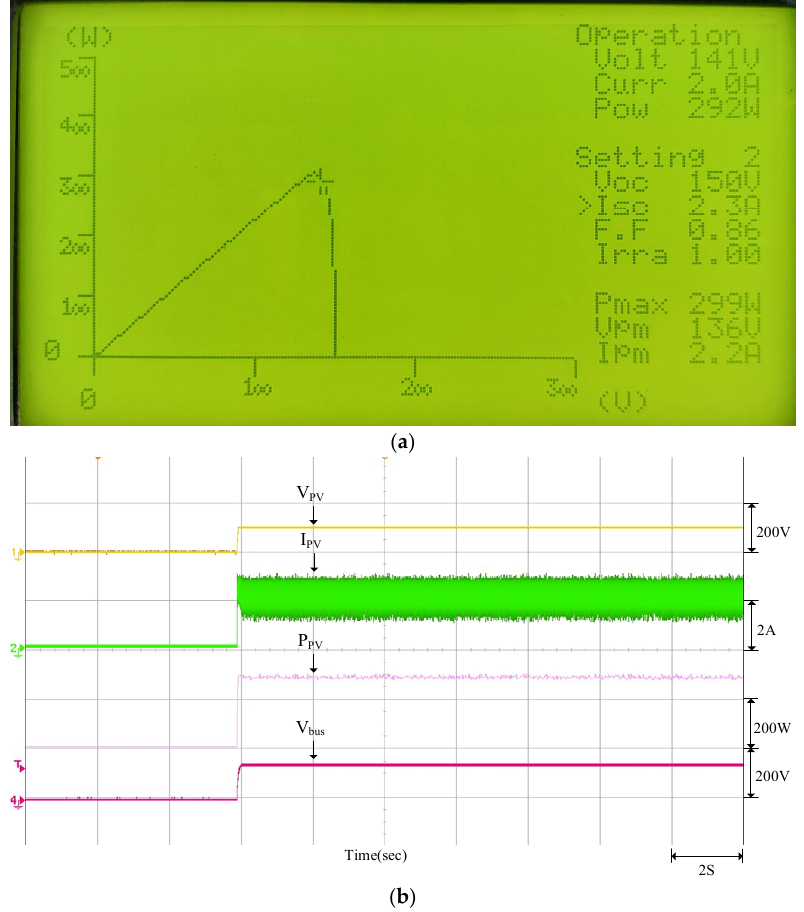
Figure 15. Under the maximum power tracking when the photovoltaic module outputs 300 W: ( a ) P–V characteristic curve diagram; ( b ) actual tested waveform.